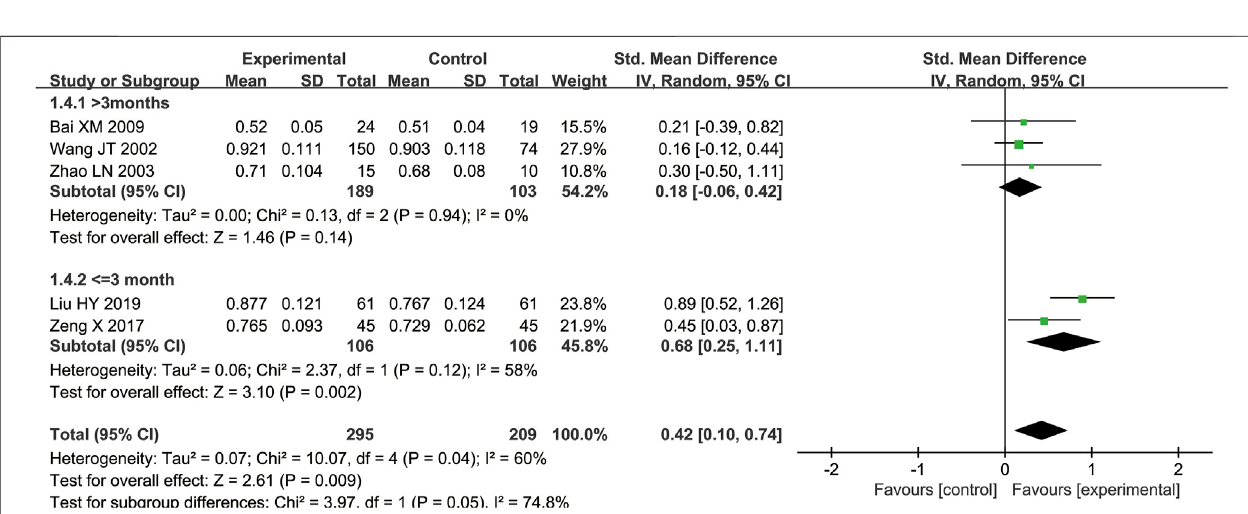
Frontiers in Pharmacology |